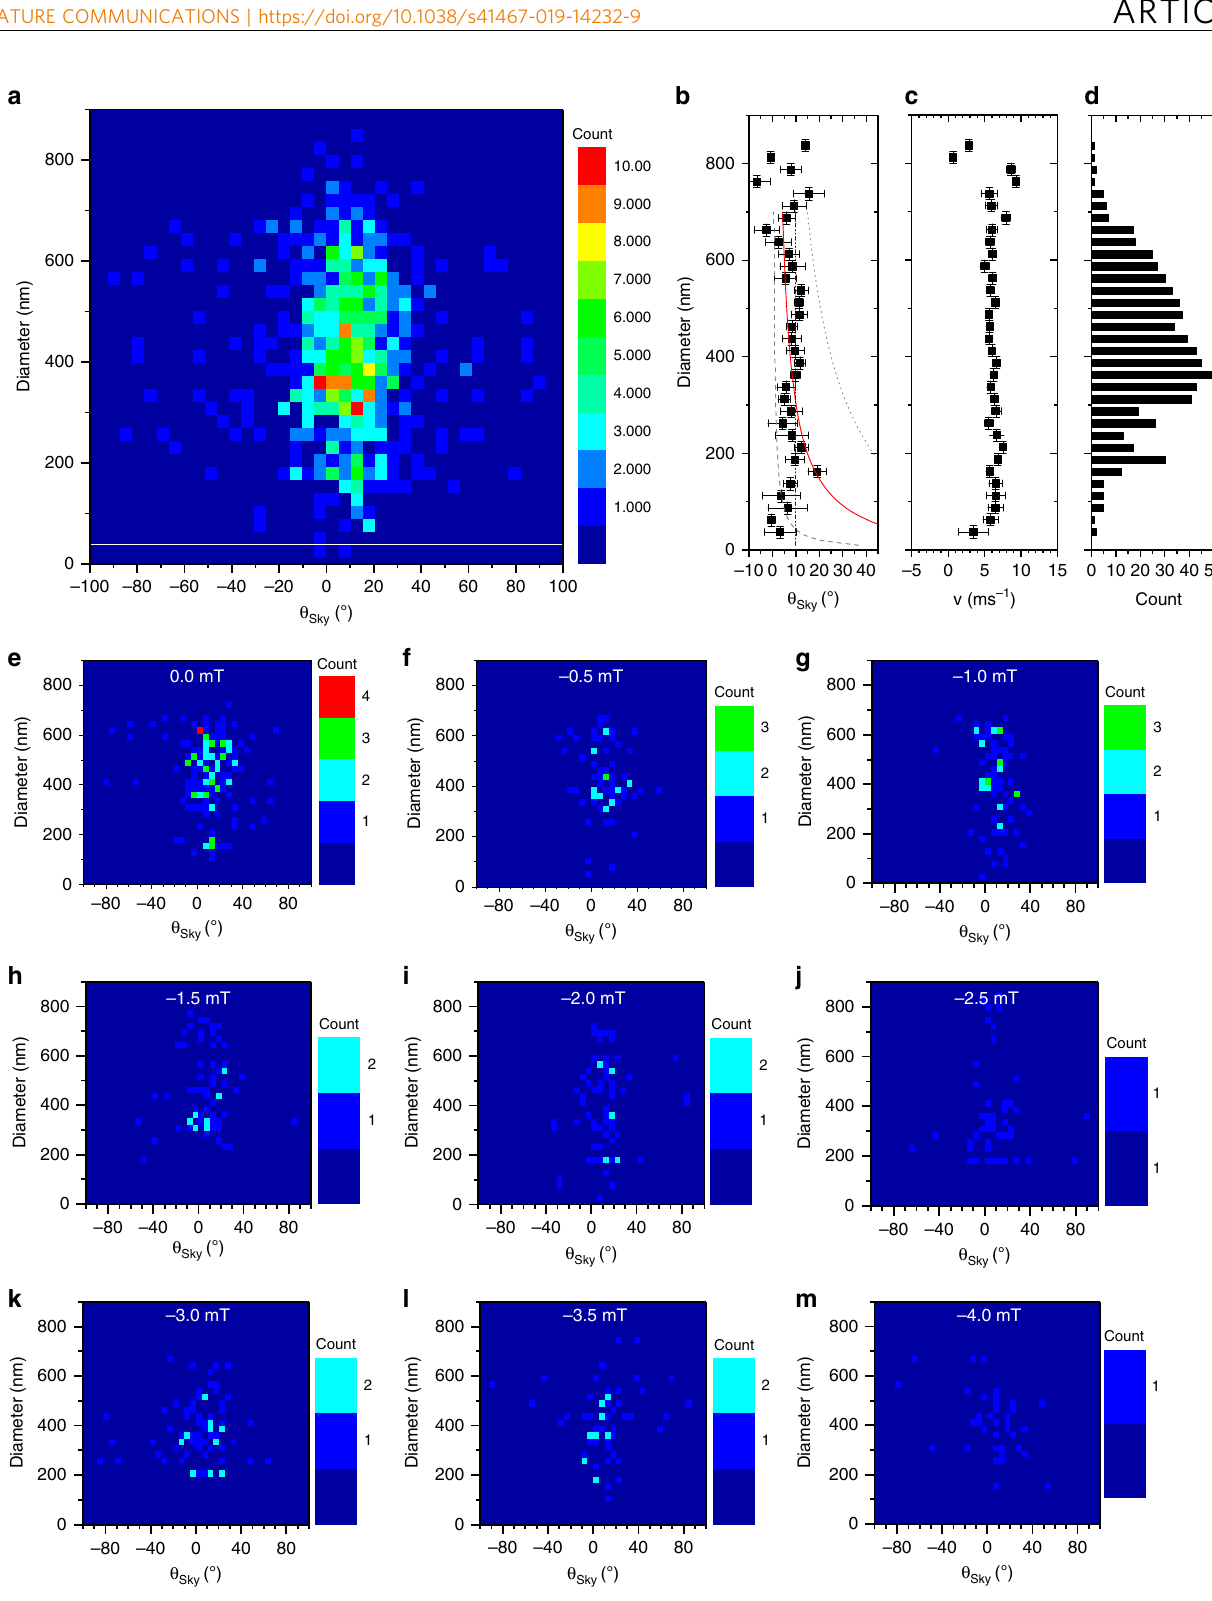
Fig. 3 Diameter-dependence of the skyrmion Hall angle. a Frequency count of skyrmion diameter versus skyrmion Hall angle θ Sky . The diameter was extracted by counting the pixel area of each moving skyrmion and evaluating the effective diameter for a perfectly circular skyrmion of the same area. The diameters and angles were binned into 25 nm and 5° intervals respectively. b Average θ Sky evaluated from data in a , and c the average velocity versus diameter with the respective histogram d . Standard error is plotted. The diameter error is given by the image resolution. The blue dash-dot-dot line shows the best linear fi t to the data, the grey dashed line, red solid line and grey dash dot line show the expected diameter dependence using the rigid skyrmion motion model with α G = 0.5, 0.07 and 0.02, respectively. e – m show diameter-skyrmion Hall angle data as a function of applied fi eld. Adding all these plots together will give the overall plot in a